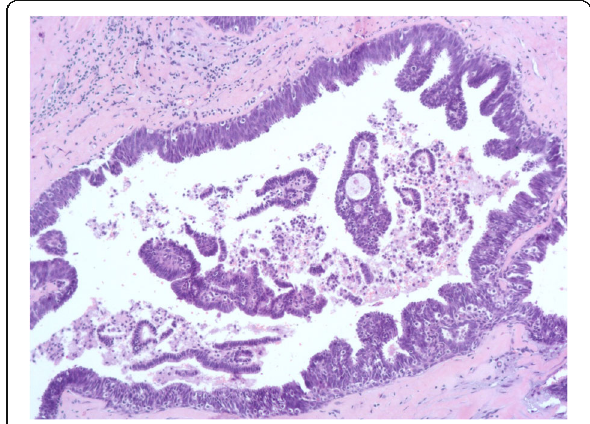
Fig. 9 Ductal carcinoma in situ: arch formation and complex architecture with real micropapillary